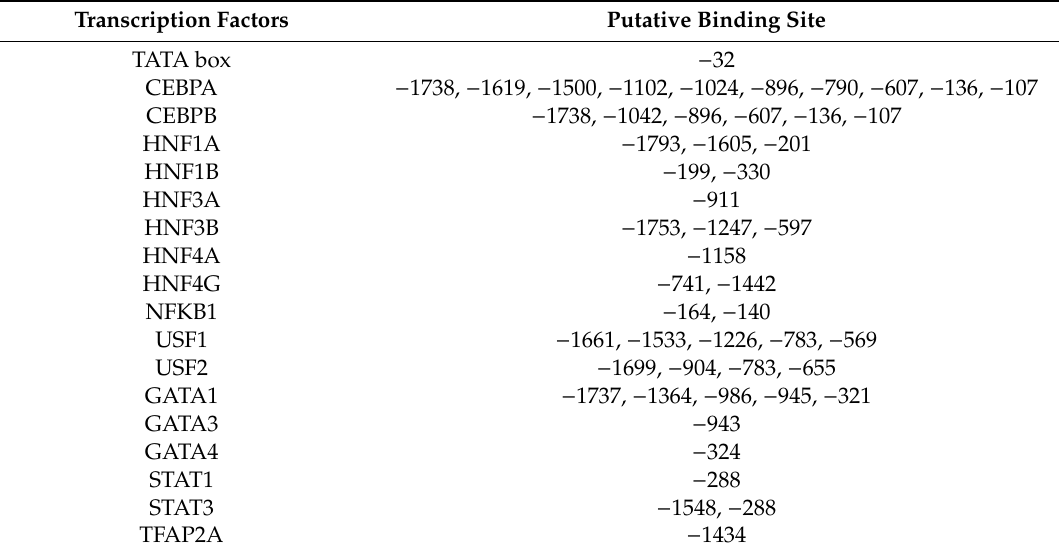
Figure A2. Analysis of iron balance and immune-related genes. ( A ): Protein–protein interaction analysis. The interactions among hepcidin (HAMP), FPN1, TFR1, FTN, IL-1 β , IL8, TNF- α , and SOCS3 proteins were analyzed using a human model. The spheres and lines represent proteins and interactions. The light blue, pink, olive, and black lines represent the analysis from the database, experimental data, text mining data, and co-expression data, respectively. ( B ): Model diagram of iron balance mechanism. Transferrin (TF) carries Fe 3 + and binds to TFR1. In this process, Fe 3 + is changed to Fe 2 + by other accessory proteins, and Fe 2 + is transported into cells by TFR1. FTN can store excess Fe 2 + in the cells. Fe 2 + is exported outside of the cells via FPN1. In this process, Fe 2 + is changed to Fe 3 + by other accessory proteins. Fe 3 + is then carried by TF and transported by blood to the site where it is stored or needed. HAMP binds to FPN1, internalizes, and degrades FPN1 to block iron output. Table A1. Transcription factor binding site